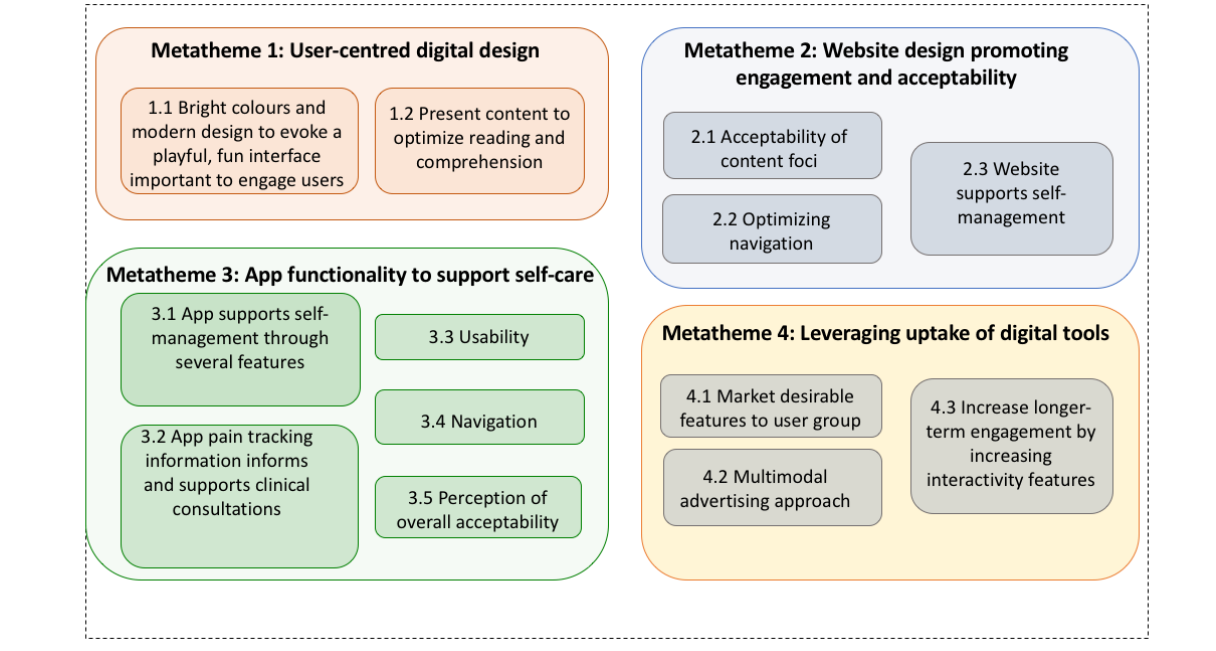
Figure 4. Graphic summary of metathemes and themes derived from qualitative interviews. Metathemes were as follows: user-centered digital design (orange), website design promoting engagement and acceptability (blue), app functionality to support self-care (green), and leveraging uptake of digital tools